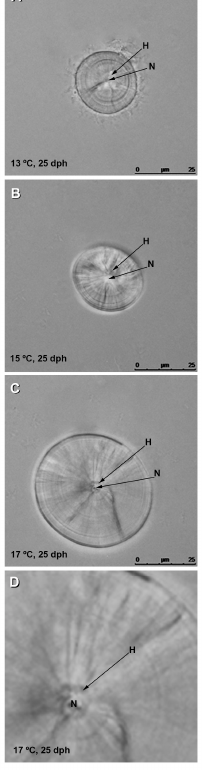
Figure 2. Relationship between age (days post-hatching, dph) and number of growth increments (GI, ( A ) and ( B )), and between age (dph) and otolith diameter ( μ m, ( C ) and ( D )) of European sardine Sardina pilchardus (Walbaum, 1792) larvae reared from 0 to 25 dph under 13, 15, and 17 °C (left panels, ( A ) and ( C )) and from 0 to 35 dph for 15 and 17 °C (right panels, ( B ) and ( D )). Results of the GLMs are presented in Table 1. The variability of increment counts at age within each treatment was very high and no significant differences of GI count were found between larvae reared at 13, 15, and 17 °C (Table 1), although mean GI counts at 17 °C at 25 days post ‐ hatching (dph) were higher than for larvae reared with the other two temperatures. The mean number of GI counted at 25 dph was 19.2, 19.8, and 26.0 GI.day − 1 for larvae reared at 13, 15, and 17 °C, respectively. Between 0 to 35 dph, larvae reared at 15 °C had similar GI counts to those reared at 17 °C, 0.9 and 1.0 GI.day − 1 , respectively.